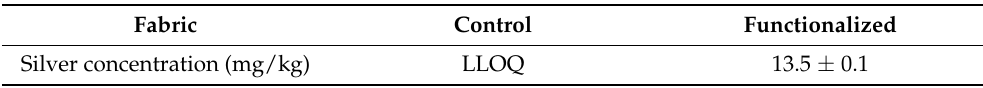
Table 1. Silver concentration (mg/kg) in cotton fabrics. Results showed as Mean ± Standard Deviation (n = 3). LOQ = 0.2 mg/kg